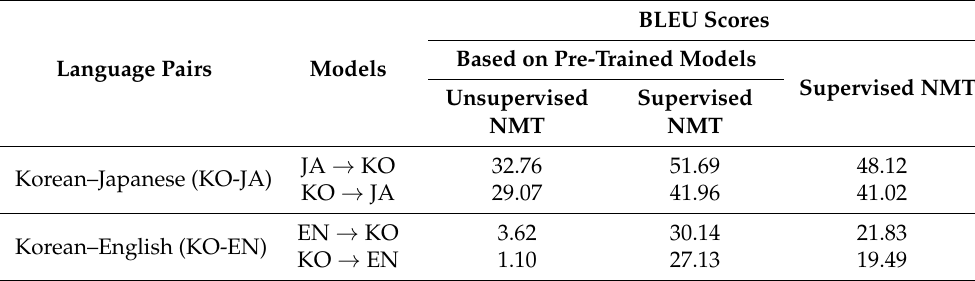
Table 3. The performances of the neural machine translation systems.